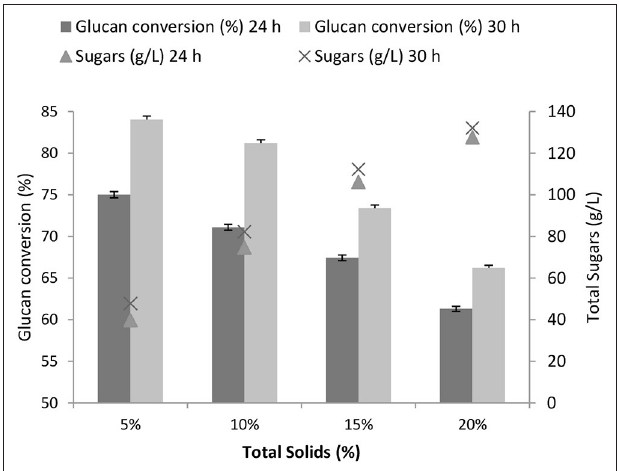
FIGURE 3 | Glucan conversion and total sugars obtained at different total solids loadings (5–20%) at 3 FPU/g TS after 24 and